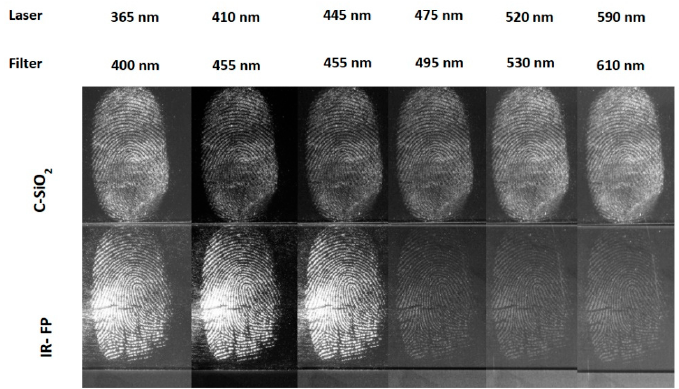
Figure 4. Fingerprints developed with C-SiO 2 nanopowder (top) and a commercial fluorescent fingerprint powder (bottom) on a glass slide, visualised with a Crime-lite imager. Reproduced from reference [42] with permission of The Royal Society of Chemistry.